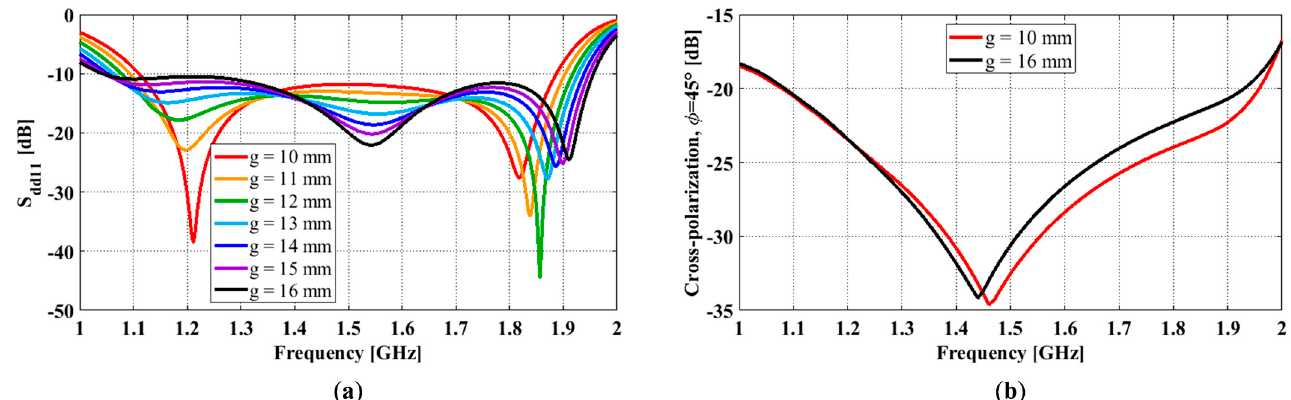
Figure 5. OCROP with different air gaps: ( a ) Differential reflection coefficient; ( b ) Peak cross-polarization ratio.